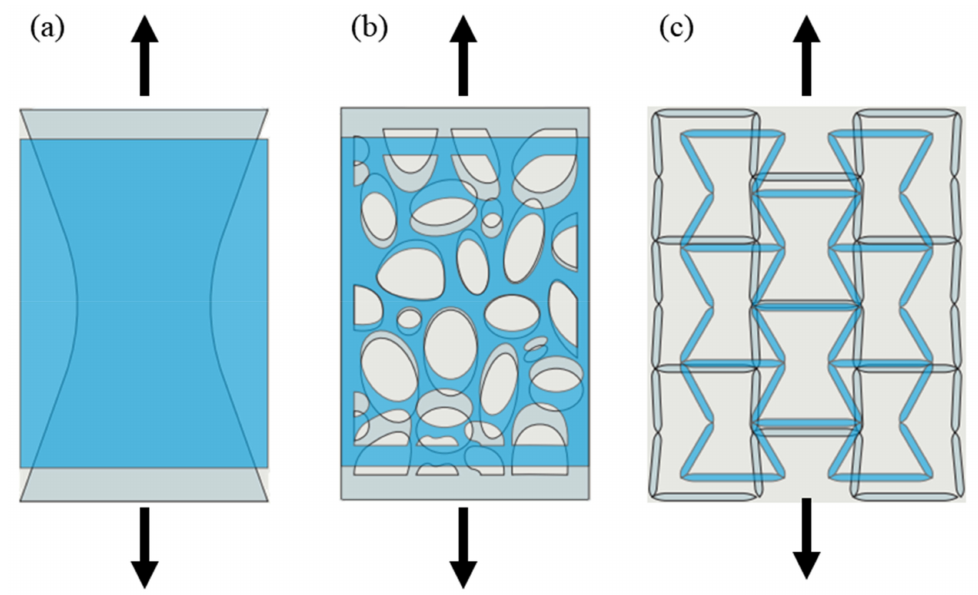
Figure 2. The three types of Poisson’s ratio: ( a ) positive, ( b ) zero, and ( c ) negative [13].